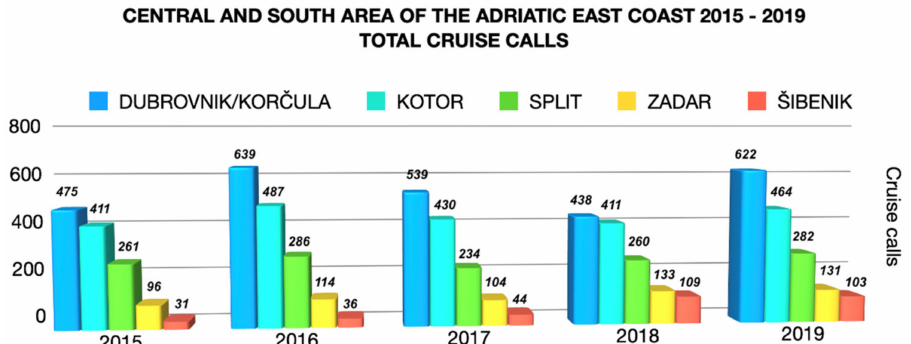
Figure 4. Total cruise calls from 2015 to 2019 in five leading ports in the central and south part of the Adriatic east coast.